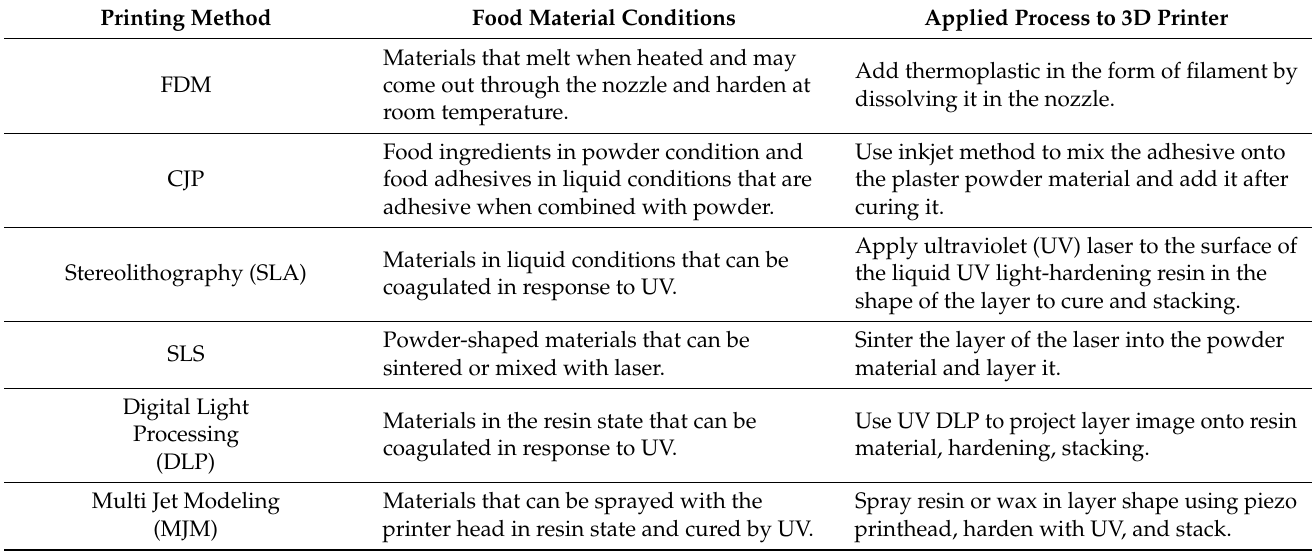
Table 2. Food material conditions according to 3D printing